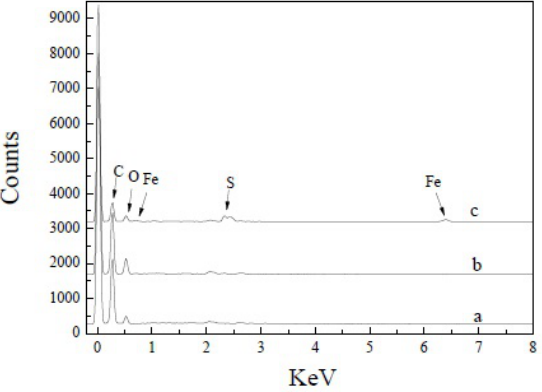
Figure 5: The energy spectrum diagrams of PRs(a), NPRs(b) and HPRs